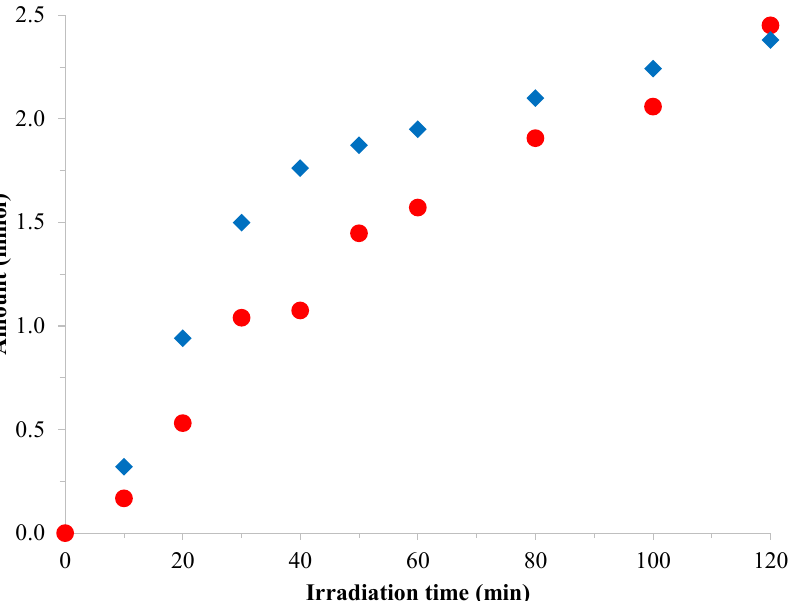
Figure 9. Photocatalytic decomposition of oxalic acid in the solution phase (  ) and H 2 production (  ) under UV irradiation and anaerobic conditions with Pt-P25 CRIS ( D Pt = 3.2 nm)